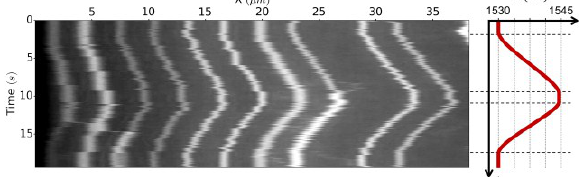
Fig. 3. Kymograph describing the continuous forward (to the right) and backward (to the left) transportation of 500 nm beads trapped in a TM 0 -TE 1 lattice by continuously varying the